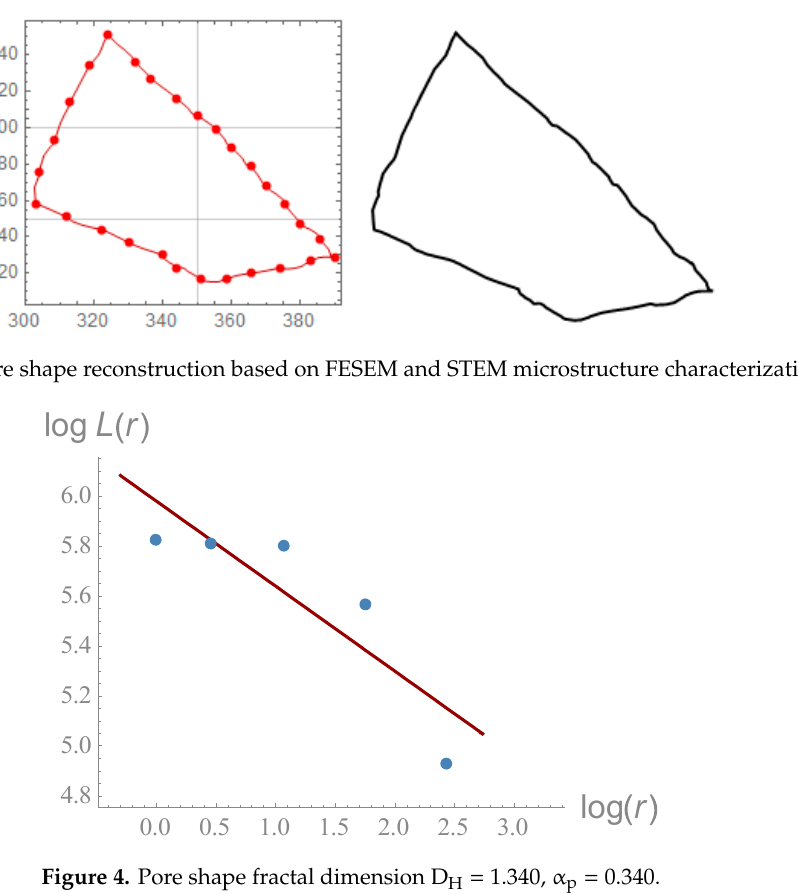
Figure 4. Pore shape fractal dimension D H = 1.340, α p = 0.340.